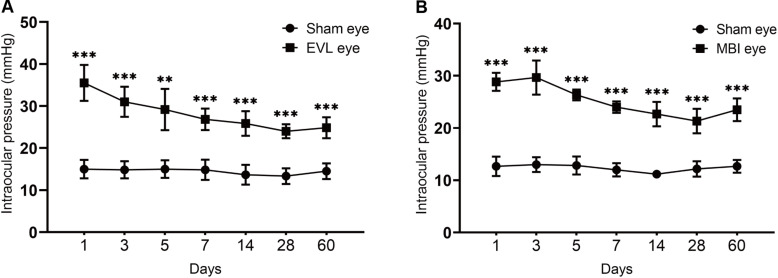
IOP of eyes in the COH groups and sham-operated group. Data are expressed as the mean ± SD. Intraocular pressure, IOP; COH, chronic ocular hypertension; EVL, episcleral vein ligation eyes (n = 6); MBI, microbead injection eyes (n = 6); sham-operated eyes (n = 6). Independent t-tests were used to analyze the IOP differences between the COH group and the sham-operated group (*p < 0.05, **p < 0.01, ***p < 0.001). (A) EVL-induced COH rat model showed significantly higher IOP than sham eyes at different time points (all P < 0.001 except for measurement at 5 days with P = 0.003). (B) There was a significant difference in IOP between sham and MBI eyes at different time points (all P < 0.001).